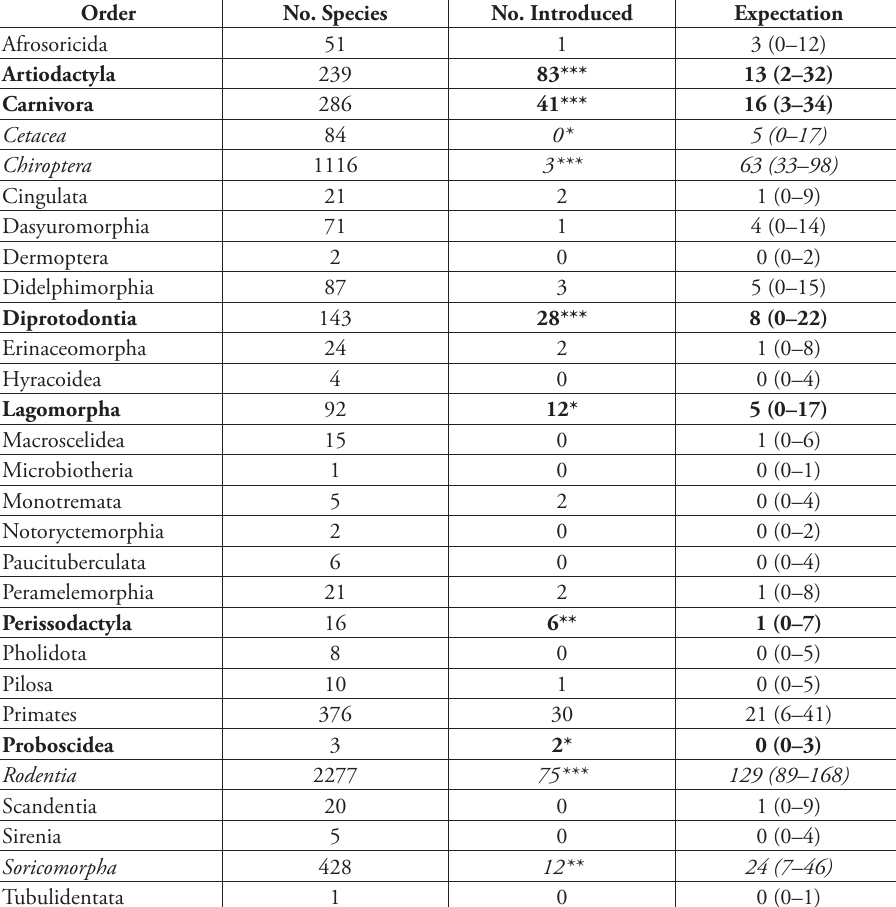
Table 2. The distribution, across mammal orders, of all mammal species (No. species), introduced mam- mal species (No. introduced), and the expected number of introduced species per order (median and range, based on 100,000 iterations of the permutation test) assuming that mammal species were selected for introduction at random (Expectation). Species numbers are based on the taxonomy in Wilson & Reeder (2005). Orders with significantly more introduced species than expected by chance are shown in bold, while orders with significantly fewer introduced species are shown in